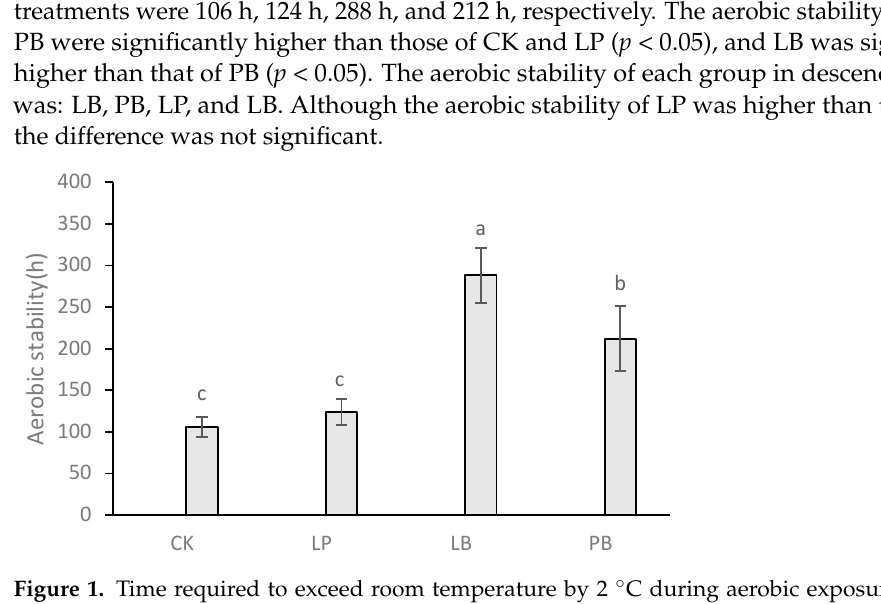
Figure 1. Time required to exceed room temperature by 2 ◦ C during aerobic exposure of native grass silage. CK, control group; LP, Lactobacillus plantarum ; LB, Lactobacillus buchneri ; PB, Lactobacillus plantarum + Lactobacillus buchneri . Different lowercase letters indicate significant differences among different treatments ( p < 0.05).